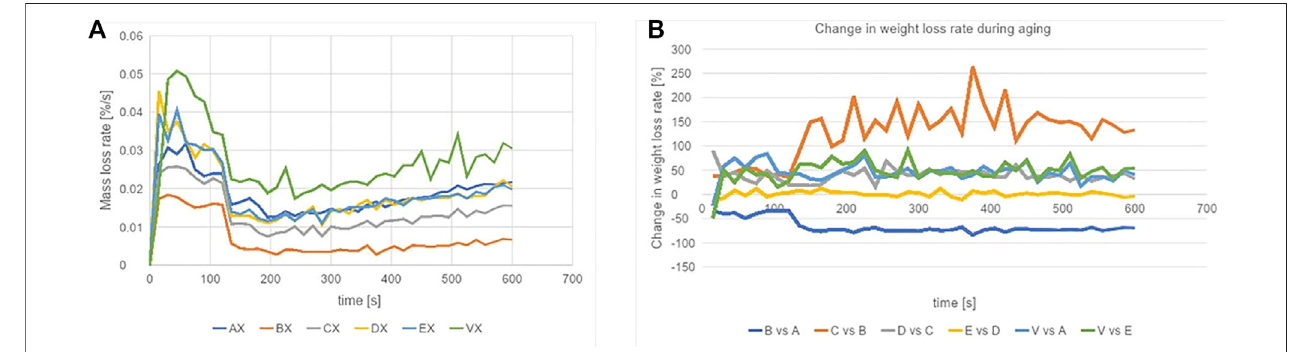
FIGURE 3 | (A) Comparison of mass loss rates between the individual samples; (B) Change in mass loss rate of samples of different ages.